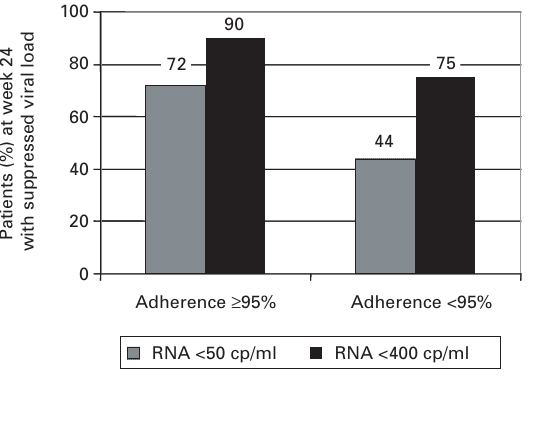
HIV-RNA suppression rates (<50 copies and <400 copies/ml) after 24 weeks of therapy in patients with taking adher- ence < and 0